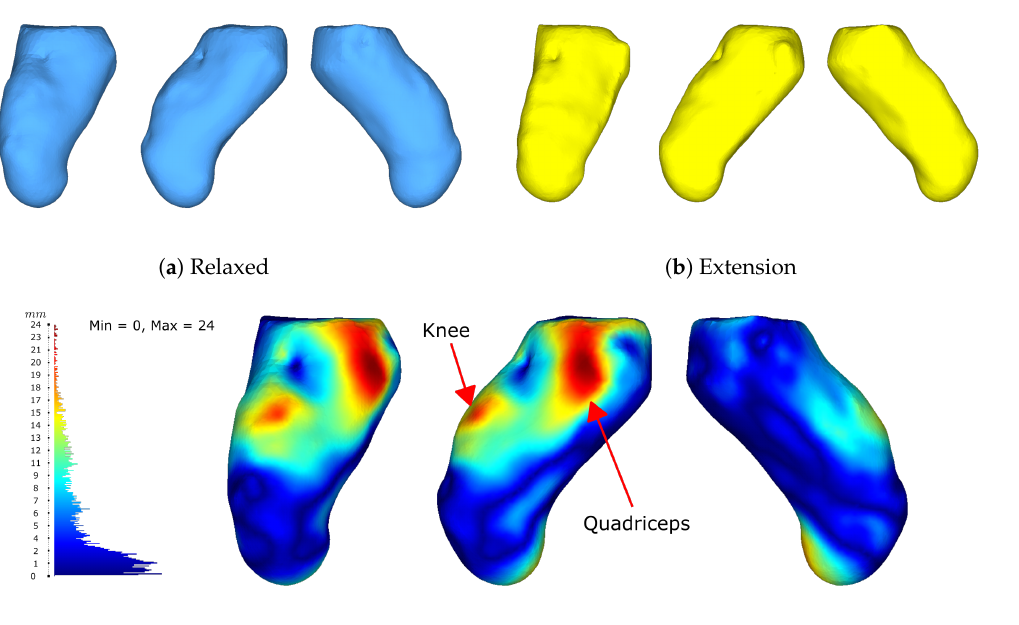
Figure 16. Results from two poses obtained from participant M6. Results measured via HD. ( a ) The residuum model in a relaxed pose, ( b ) the residuum model while co-contracting the muscles, and